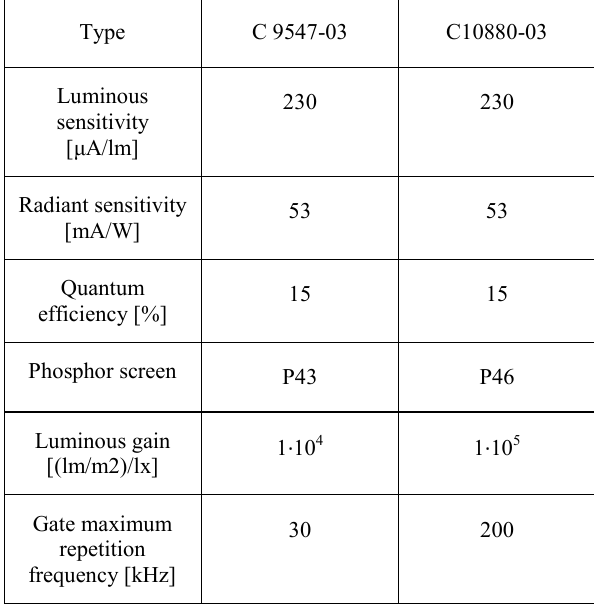
Table 1. Image intensifiers